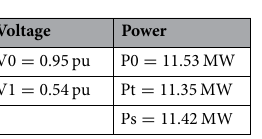
Figure 20. Policentro bus point selection for voltage studies ( a ) and Power studies ( b ).